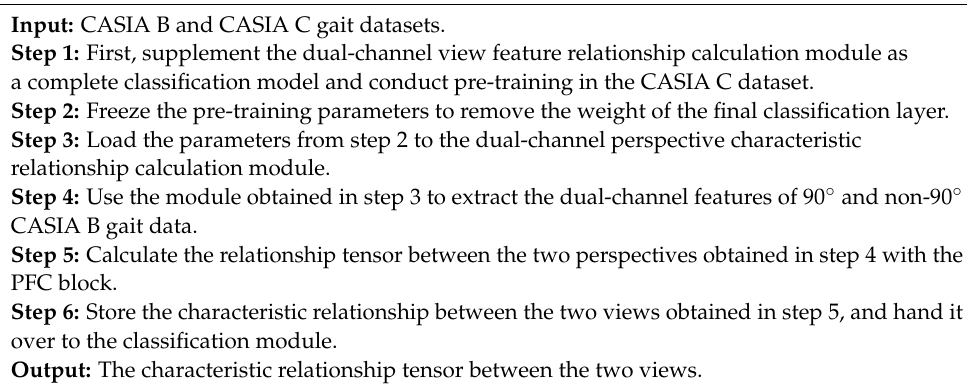
Algorithm 1: Process of training the characteristic view relationship calculation module.